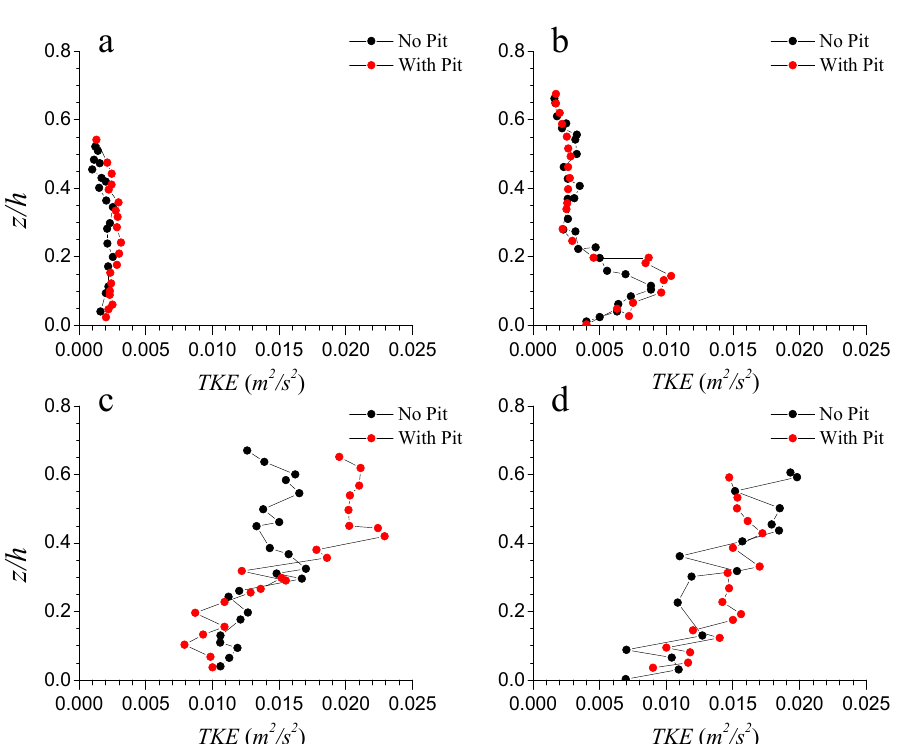
Figure 7. Turbulent kinetic energy ( TKE ) profiles at ( a ) Location 1, ( b ) Location 2, ( c ) Location 3, and ( d ) Location 4.